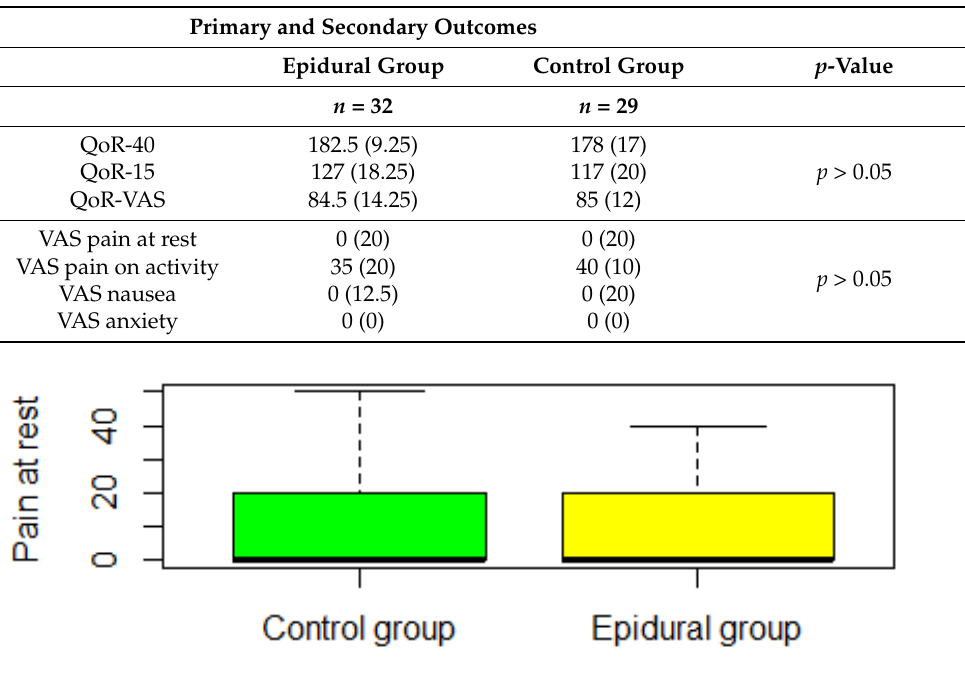
Figure 3. The VAS pain at rest score was obtained at the end of the analgesia protocol. This distribution is shifted toward zero, therefore the median is zero and the box is shorted.